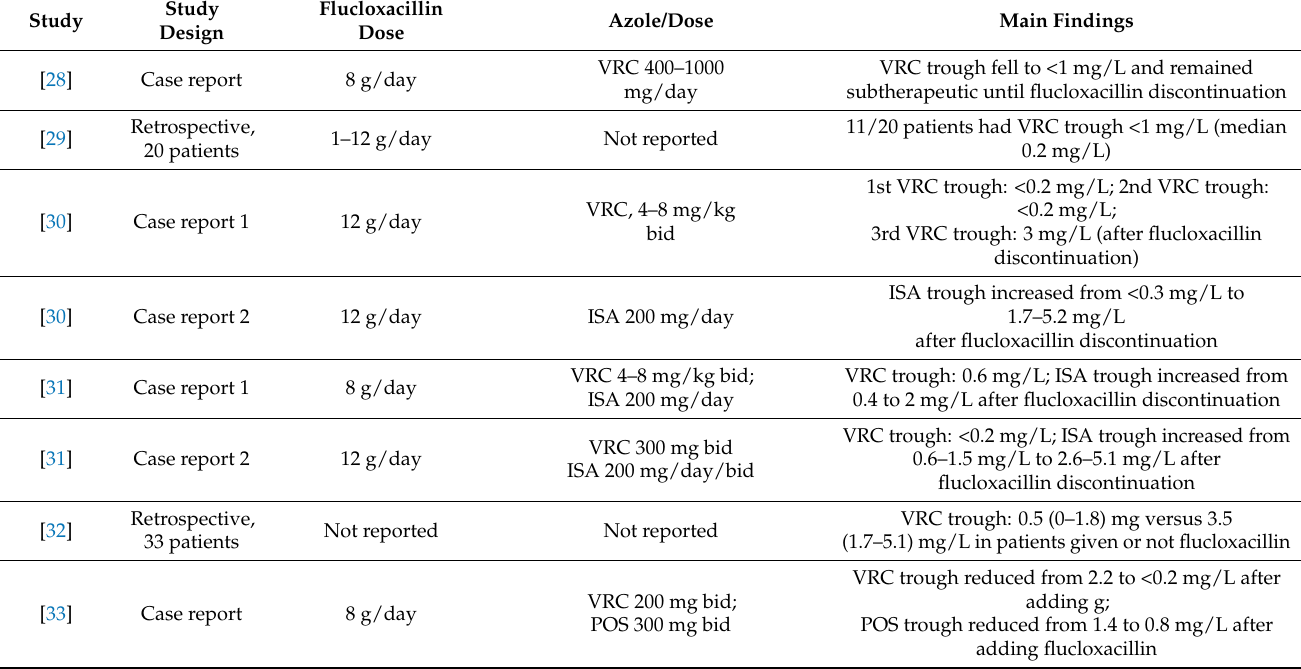
Table 2. Studies that have documented drug-drug interactions between flucloxacillin and antifungal